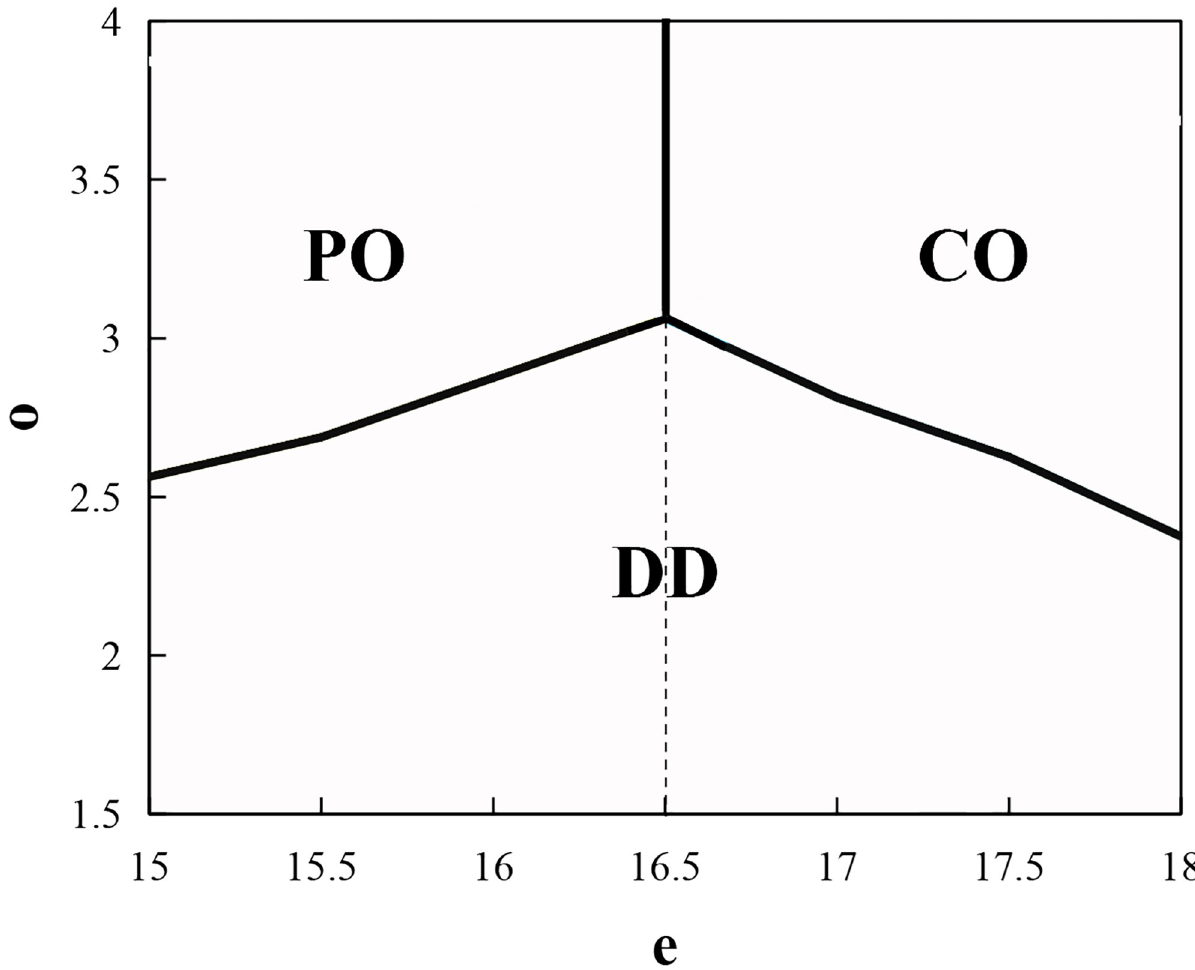
Fig 6. The supplier’s selection of contracts under risk-averse retailer and